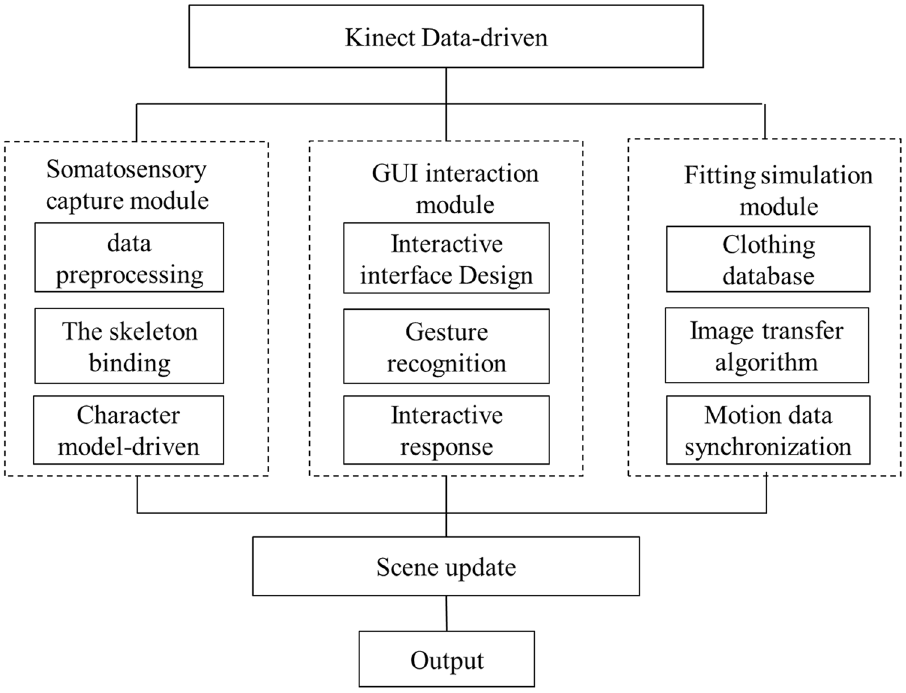
Figure 1. System flow